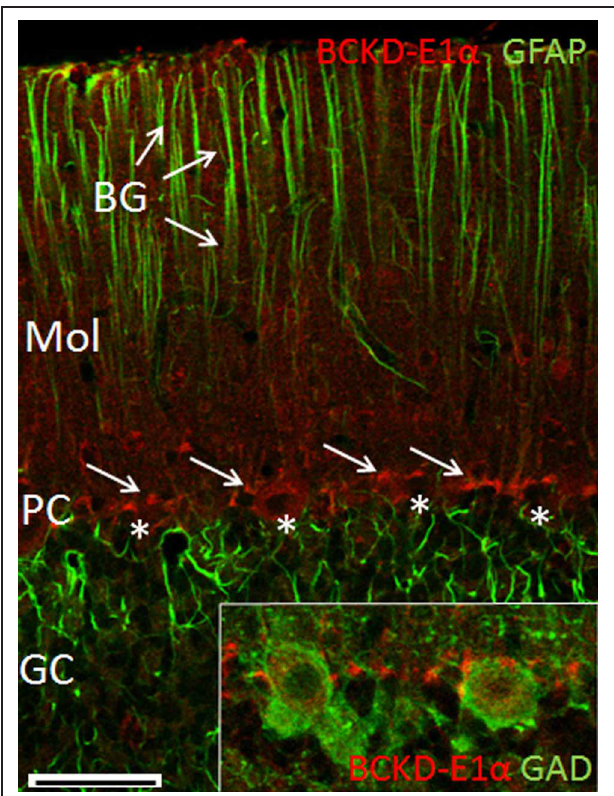
FIGURE 5 | Immunolocalization of BCKDC-E1 α in the cerebellar cortex. Co-localization of BCKDC-E1 α (red) and GFAP (green) in the cerebellar cortex. Labeling for BCKDC is very prominent in structures located along the plane of Purkinje cell bodies (PC, cells marked by ∗ ; BCKDC label indicated by arrows). Label for BCKDC is also seen in some cells of the molecular layer (Mol). Immunolabel for GFAP is associated with the distal process of the Bergmann glial cells (BG, arrows) and with astrocytes in the granule cell layer (GC). (Inset) Merged image of co-labeling for BCKDC (red) and glutamate dehyrogenase (GAD), a marker for GABAergic cells. Purkinje cell bodies are clearly demarcated by anti-GAD. Strongest labeling for BCKDC is either at the far periphery of the Purkinje cells, in a distinct structure associated with surfaces of Purkinje cell bodies. Scale bars: (A) 50 μ m. (B–E) 25 μ m.